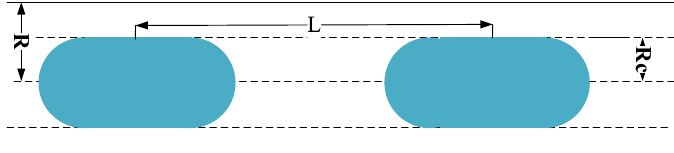
Figure 2. Slug flow in the pore.